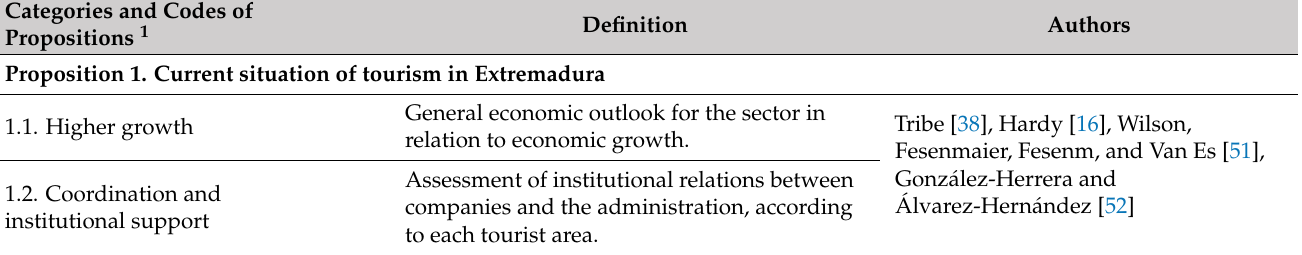
Table 3. Categories and codes. Reference authors of the research